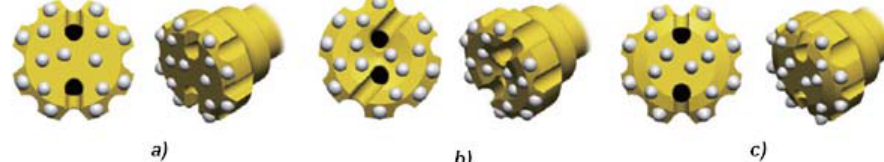
Figure 7. Heads of drill bits ( a ) flat—to be used in hard, medium-hard, and abrasive rocks (e.g., granite, basalt, and hard limestone); ( b ) concave—to be used in hard, medium-hard, and homogeneous rocks (e.g., granite, hard limestone). Good control of borehole axis deflection and washing of the bottom of the borehole; ( c ) convex—to be used in soft and medium-hard rocks, not in abrasive rock (e.g., shales, limestone, sandstones). Very good advance of drilling works)